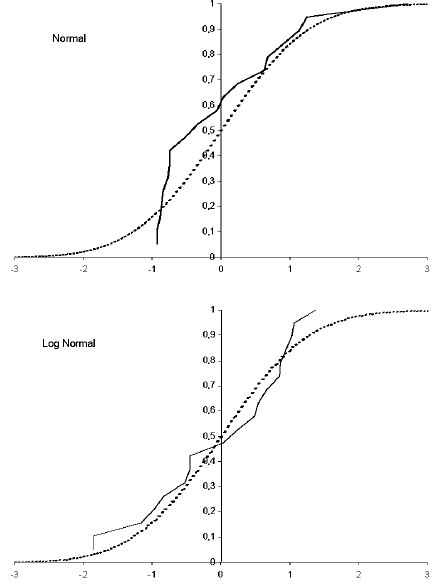
Fig. 2. The cumulated probability distribution of the distance estimation errors (solid curves) under the assumption that the errors are normally distrib - uted (top figure) and the assumption that they are log-normally distributed (bottom figure). The dotted curves show the theoretically expected curves of the normal and the log-normal distribution (the log-normal distribution is transformed into normal distribution for